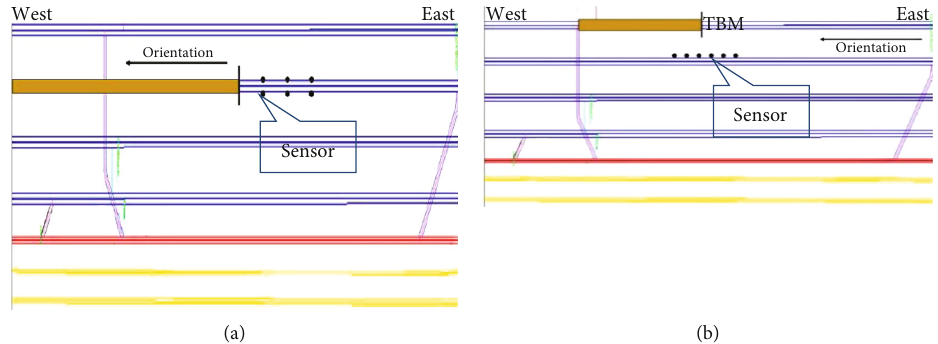
Figure 18: A map of the monitoring system of the microseismic monitoring system of the hydropower station in Jinping hydropower station of Yalong River Basin.